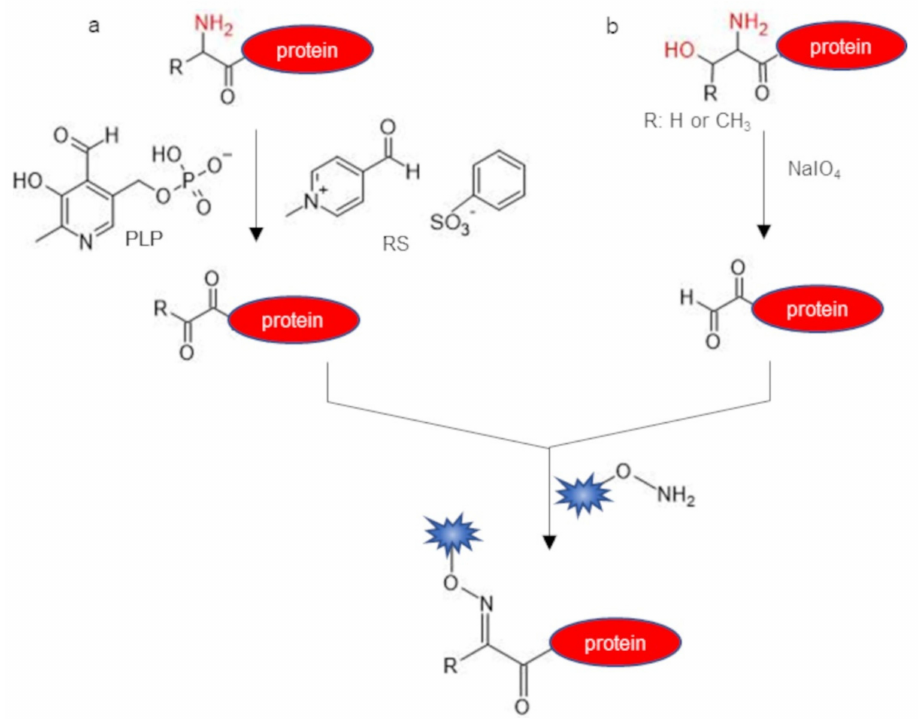
Figure 4. Two-step N-terminal protein labeling. ( a ) Transamination reaction with pyridoxal-5 (cid:48) -phosphate (PLP) or with N-methylpyridinium-4-carboxaldehyde benzenesulfonate salt (Rapoport’s salt, RS), leading to a N-terminal ketone protein; ( b ) oxidation with sodium periodate (NaIO 4 ) of 1,2 amino alcohol (N-terminal Ser or Thr), affording a N-terminal aldehyde protein. The ketone/aldehyde function installed at the protein N-terminus can be further reacted with an aminooxy-probe via oxime